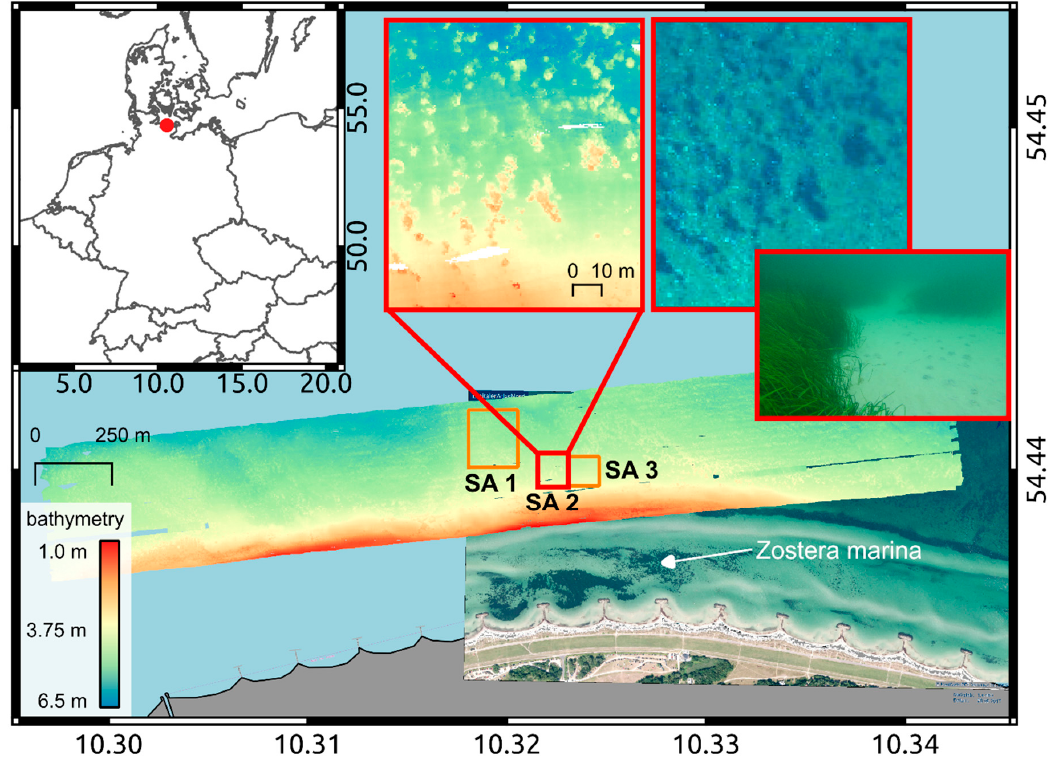
Figure 1. Survey area off Heidkate, Germany. The recorded gridded bathymetry and an aerial image are superimposed over an Openstreetmap chart. The chosen subareas (SA1, SA2, SA3) for testing our approach are marked by rectangles. SA2 (red rectangle) is presented as close up inlets showing bathymetry, aerial and diver photography.